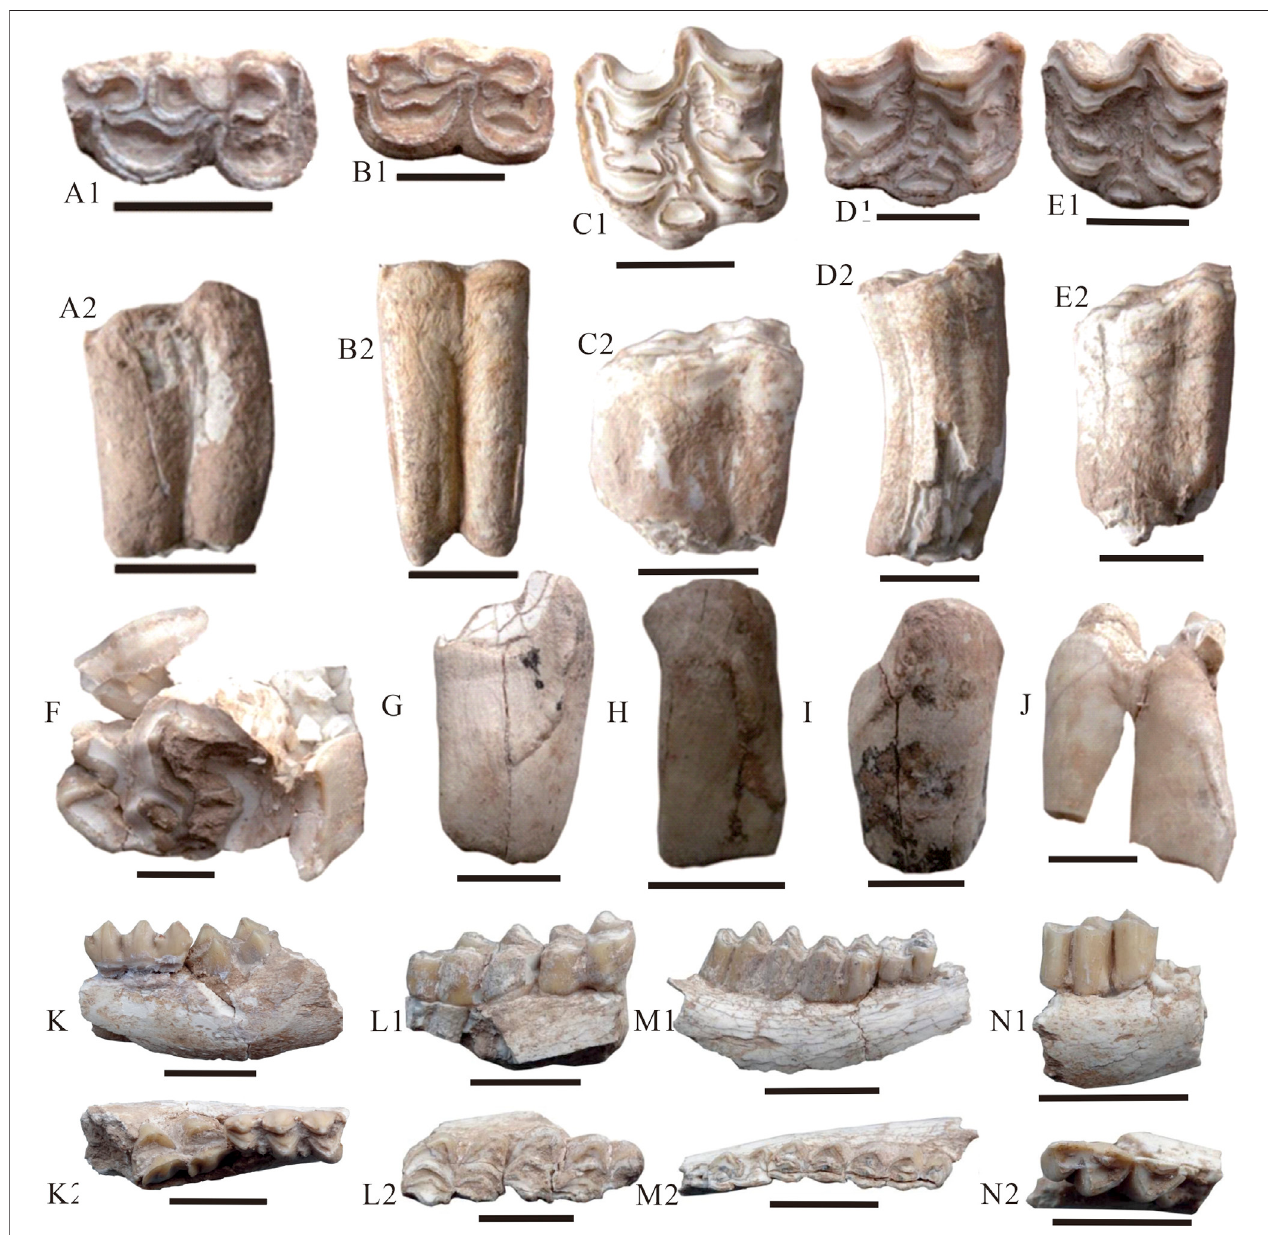
FIGURE 3 | The segmental cheek teeth for enamel carbon and oxygen isotopic compositions from Xigou section in the Xunhua Basin. Scale bar (cid:2) 2 mm; 1 (cid:2) coronal views; 2 (cid:2) side views. (A) Hipparion platyodus Selve,CUG-XH-1, lowerteeth, rightM3; (B) Hipparion platyodus Selve, CUG-XH-2, lowerteeth, rightM1; (C) Hipparionplatyodus Selve,CUG-XH-3,upper teeth,leftM1; (D) Hipparionplatyodus Selve,CUG-XH-4,upper teeth,leftM2; (E) Hipparion platyodus Selve,CUG-XH-5, upper teeth, left M2; (F – G) Tooth fragment of Chilotherium sp., and their number are CUG-XH-28, CUG-XH-29, CUG-XH-30, CUG-XH-31, CUG-XH-32, respectively; (K) Gazellagaudryi Schlosser,CUG-XH-39,leftmandible; (L) Gazellagaudryi Schlosser,CUG-XH-42,rightmandible; (M) Gazellagaudryi Schlosser,CUG- XH-47, left mandible; (N) Gazella gaudryi Schlosser, CUG-XH-51, left mandible.